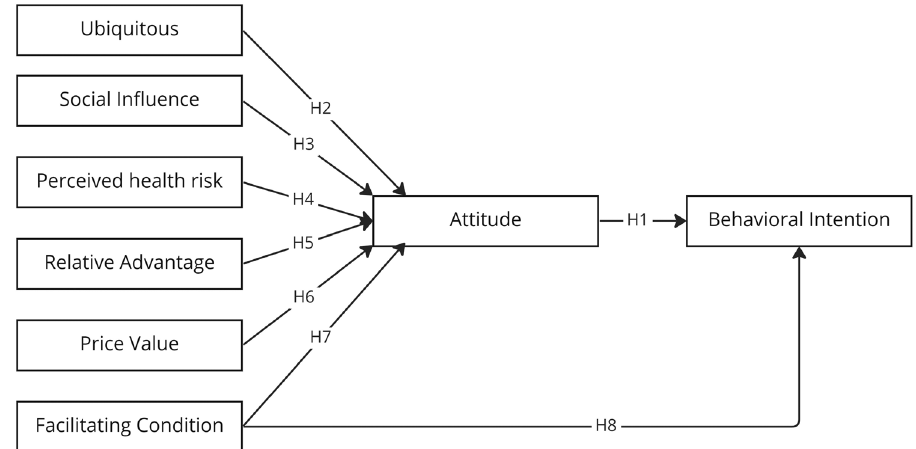
Figure 2: Hypothesized research